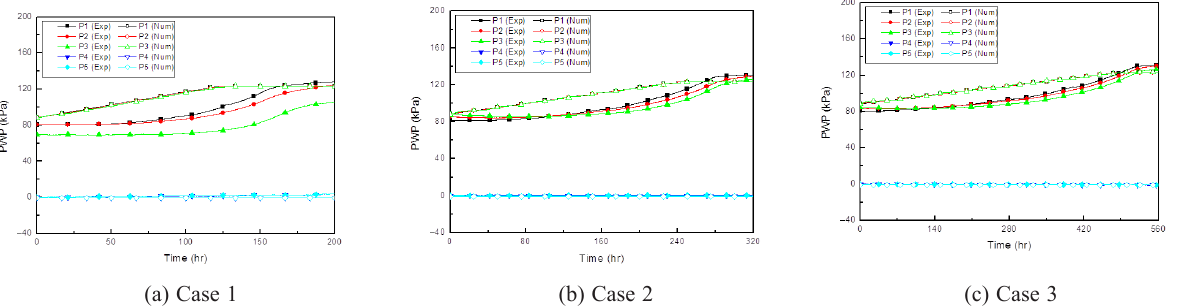
Fig. 11. Time histories of pore water pressures obtained by numerical simulation and test (after 62.5